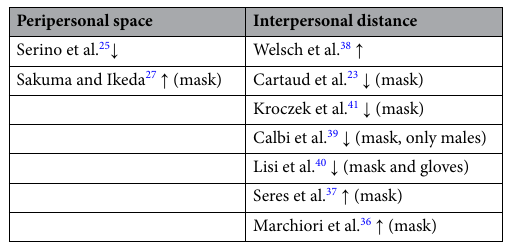
Table 1. Overview of studies on peripersonal space and interpersonal distance. ↑ Stands for increase, ↓ stands for decrease of peripersonal space and interpersonal distance,